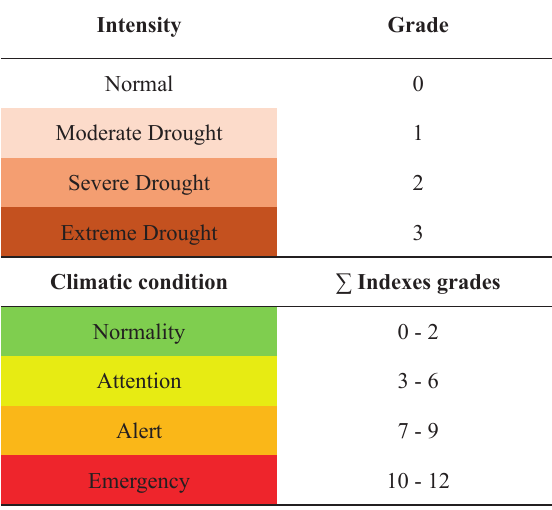
Notes for the drought intensity classes and annual drought classification system based on the global grading